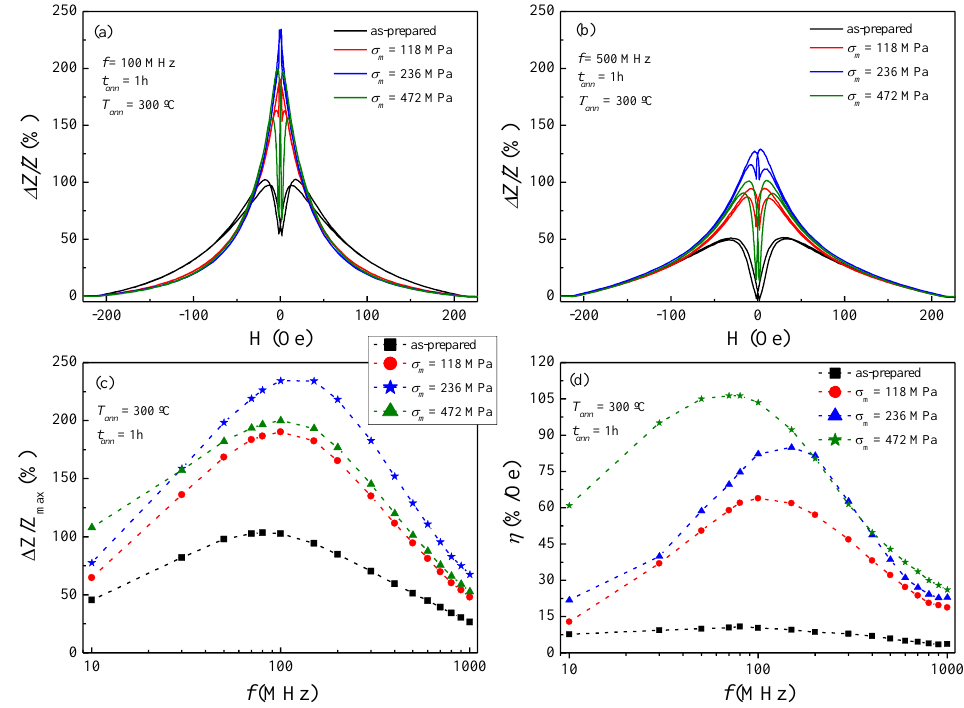
Figure 5. Field dependence of the GMI ratio for the as-prepared and stress-annealed Co 69.2 Fe 3.6 Ni 1 B 12.5 Si 11 Mo 1.5 C 1.2 microwires measured at 300 ◦ C: ( a ) 100 MHz and ( b ) 500 MHz; ( c ) frequency dependence of ∆ Z / Z max , and ( d ) field sensitivity. Dashed-lines in ( c , d ) are a guide to the eye, while full-symbols denote experimental data.